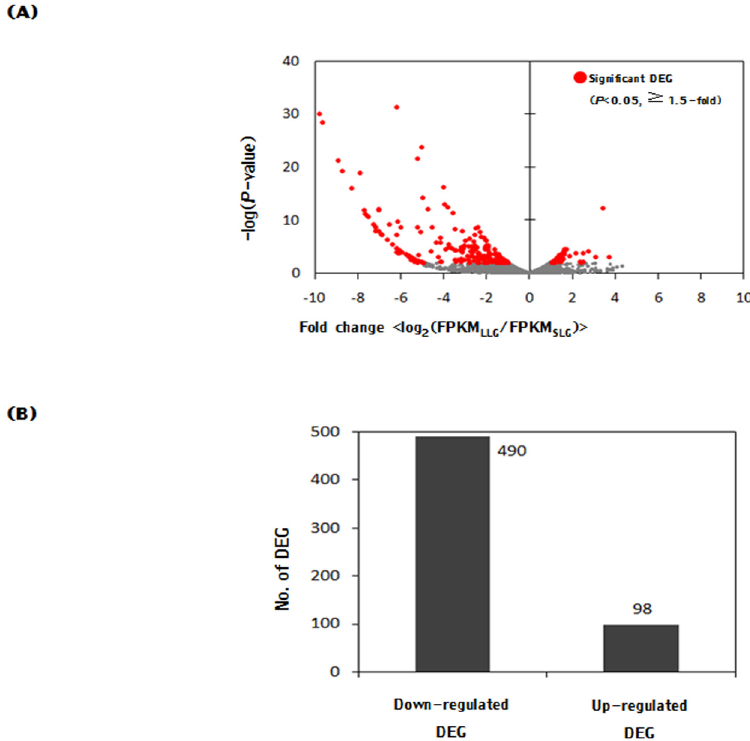
Fig 2. Distribution of DEGs. (A) The dot graph shows each DEG between the LLG and SLG. log 2 -fold change between fragments per kilobase of exon per million reads mapped (FPKM) in the SLG and LLG according to the Cufflinks package are presented along the x axis. Red dots represent significantly altered DEGs between the LLG and SLG ( p < 0.05, fold change > 1.5, the decimal system). The y axis indicates significance as -log ( p value). (B) The number of downregulated and upregulated DEGs in the LLG compared with the